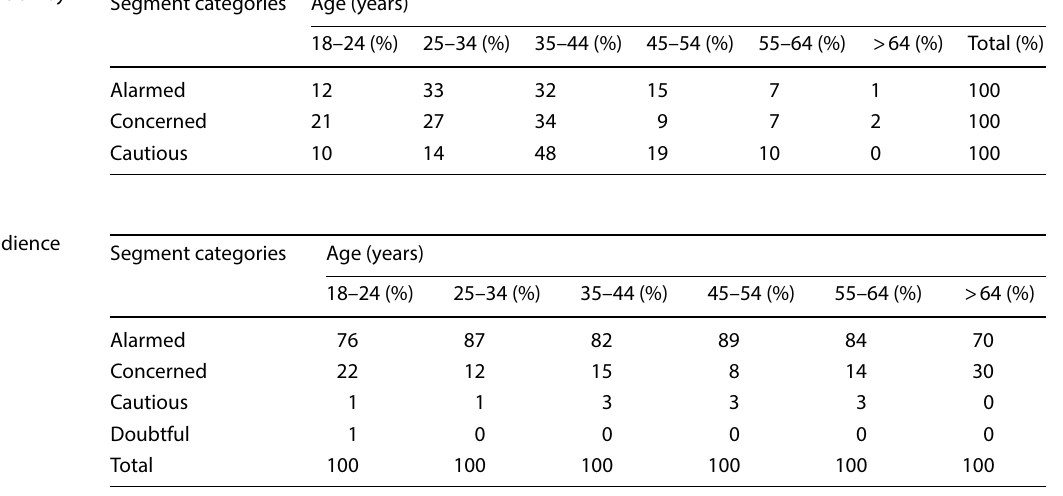
Table 6 Age participation by audience segments